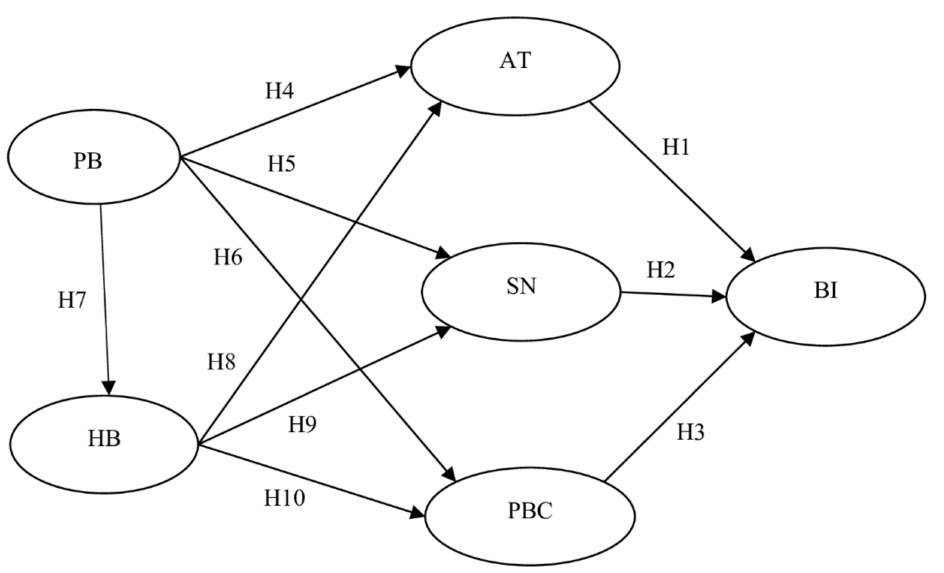
Figure 1. Framework of the proposed